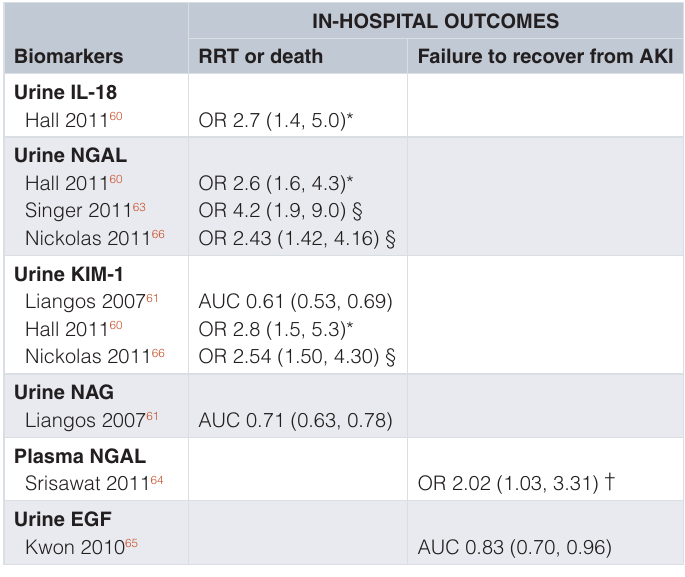
Table 5. Biomarkers of AKI and outcomes in heterogeneous